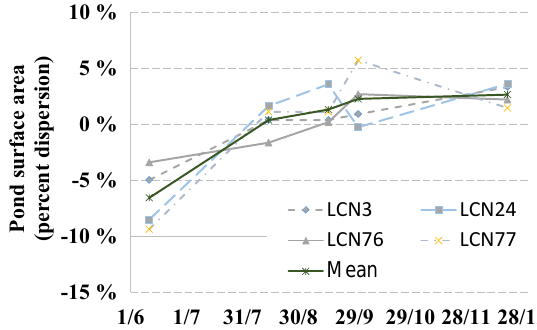
Figure 3. Intra-annual analysis (June–December) of selected pond surface areas. Percent dispersions are computed dividing the anomalies by the